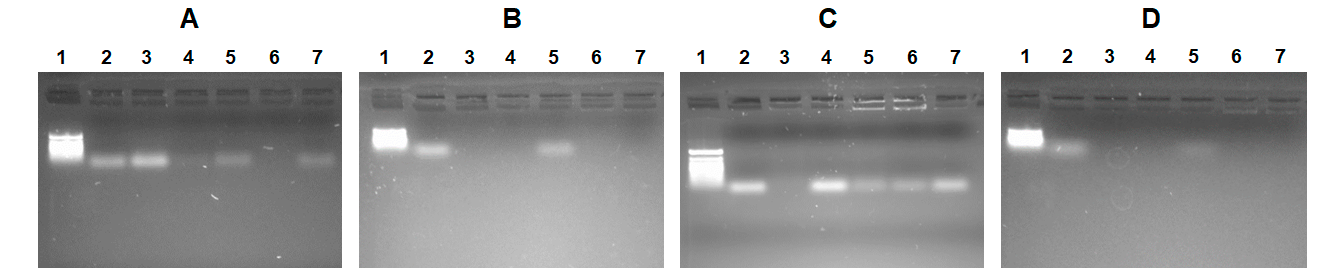
Figure 4. Agarose gel electrophorese images: Arg-containing polypeptide/oligo-dT-dA ratio = 8 ( A ), Arg-containing polypeptide/oligo-dT-dA ratio = 12 ( B ), His-containing polypeptide/oligo-dT-dA ratio = 12 ( C ), His-containing polypeptide/oligo-dT-dA ratio = 16 ( D ). Lanes: 1—markers; 2—free oligo-dT-dA; ( A , B ) 3—P[KK(F)K(R)]@oligo-dT-dA; 4—P[KK(V)K(R)]@oligo-dT-dA;